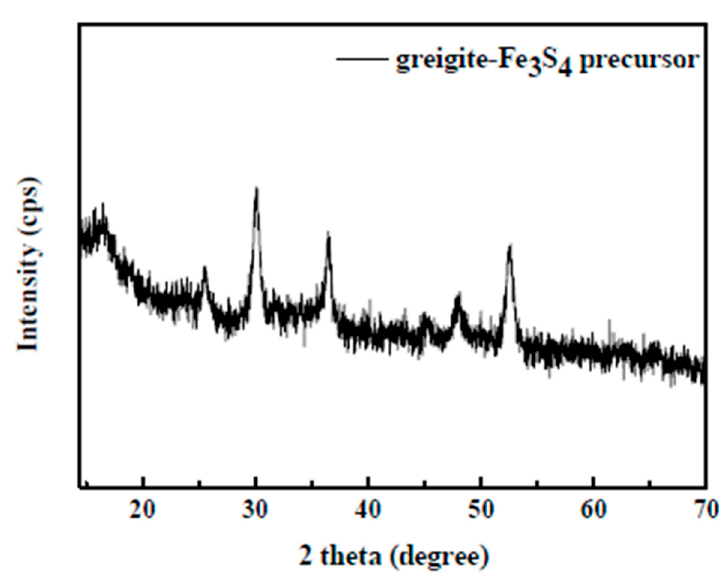
Figure 1. X-ray di ff raction (XRD) pattern of the obtained greigite Figure 1. X-ray diffraction (XRD) pattern of the obtained greigite precursor.